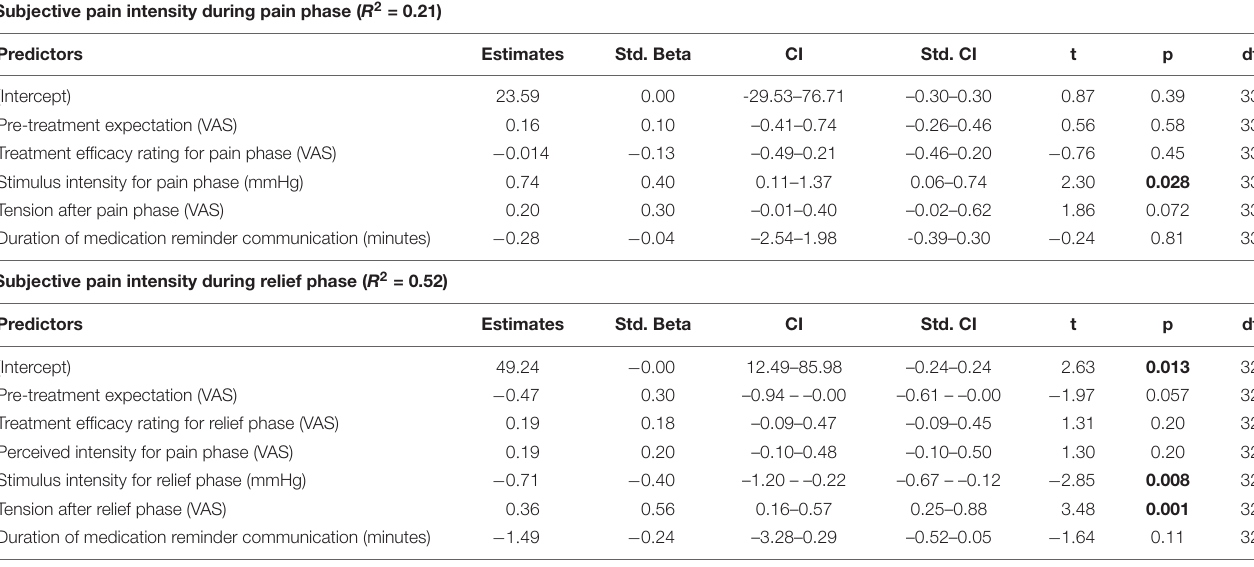
TABLE 3 | Predictors of pain intensity during pain and relief phases (Results of generalized linear models, GLM). Subjective pain intensity during pain phase ( R 2 = 0.21)